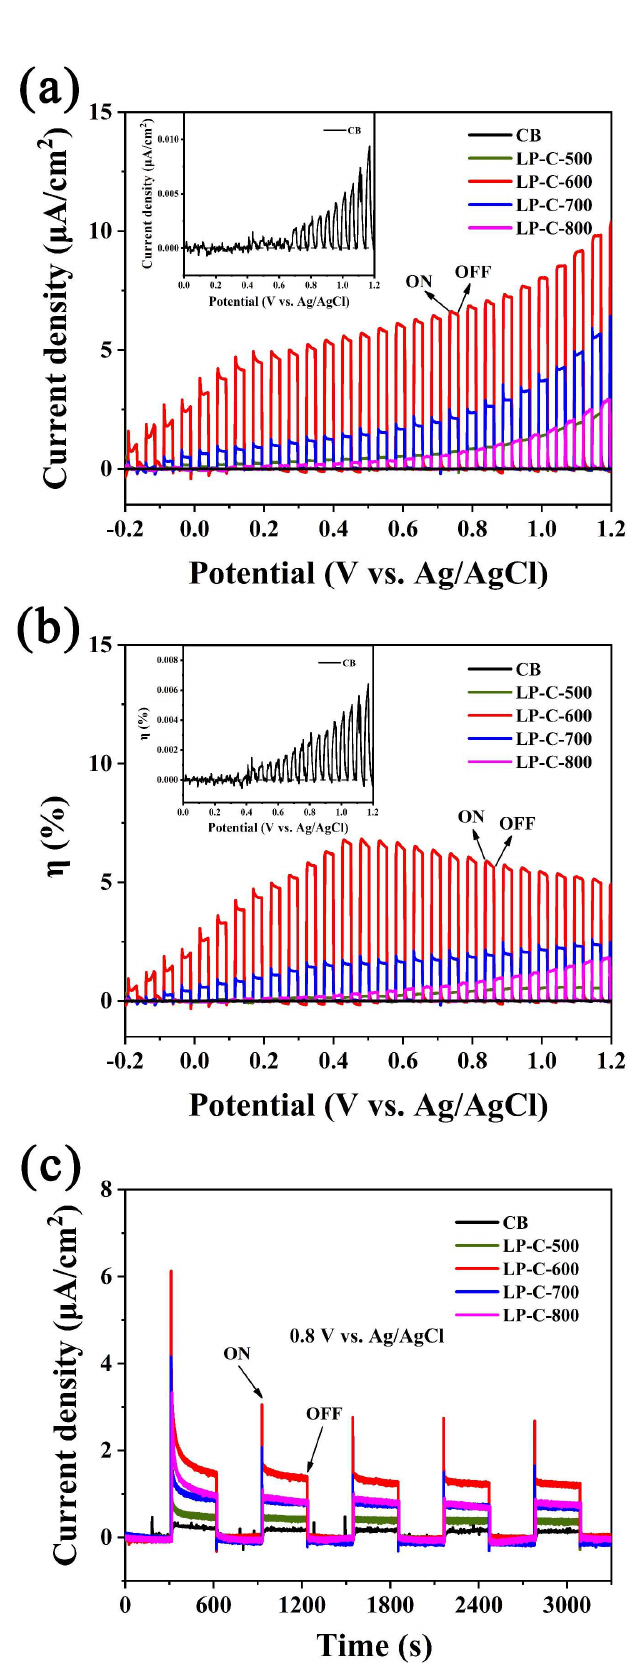
Figure 7. ( a ) Linear sweep voltammogram (LSV) curves, ( b ) photoelectric conversion efficiency, and ( c ) photocurrent density time plot at applied voltage of 0.8 V of samples under test conditions with 0.1 M Na 2 SO 4 .